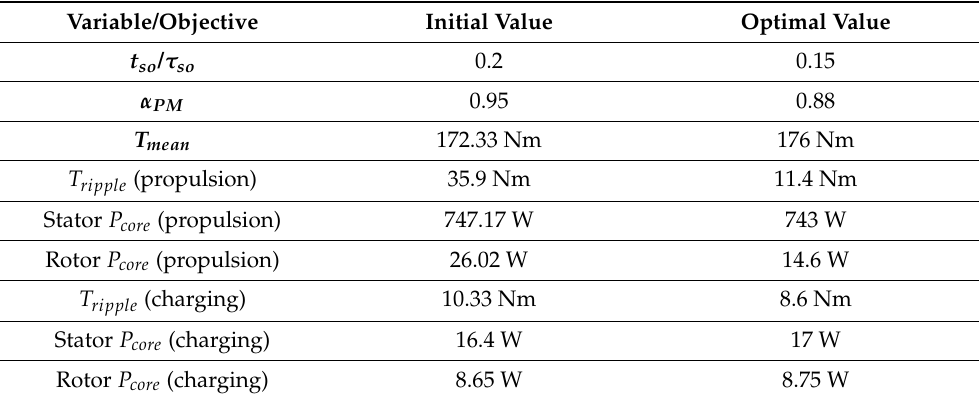
Figure 12. Optimization results of the three objectives for the dual three-phase machine under various operational modes: ( a ) Propulsion and ( b ) charging. Table 5. Optimal machine